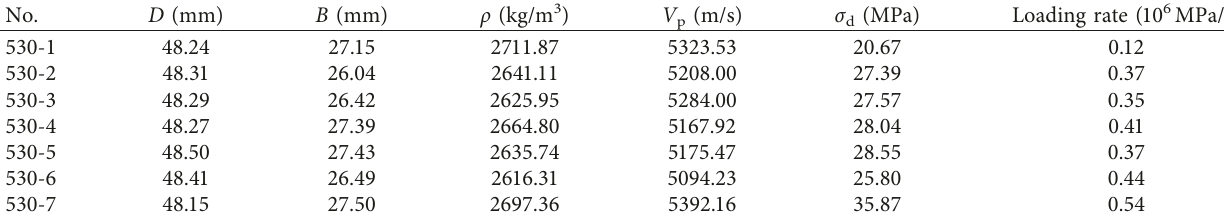
Table 8: Testing result of the dynamic tension test at depth 530m.